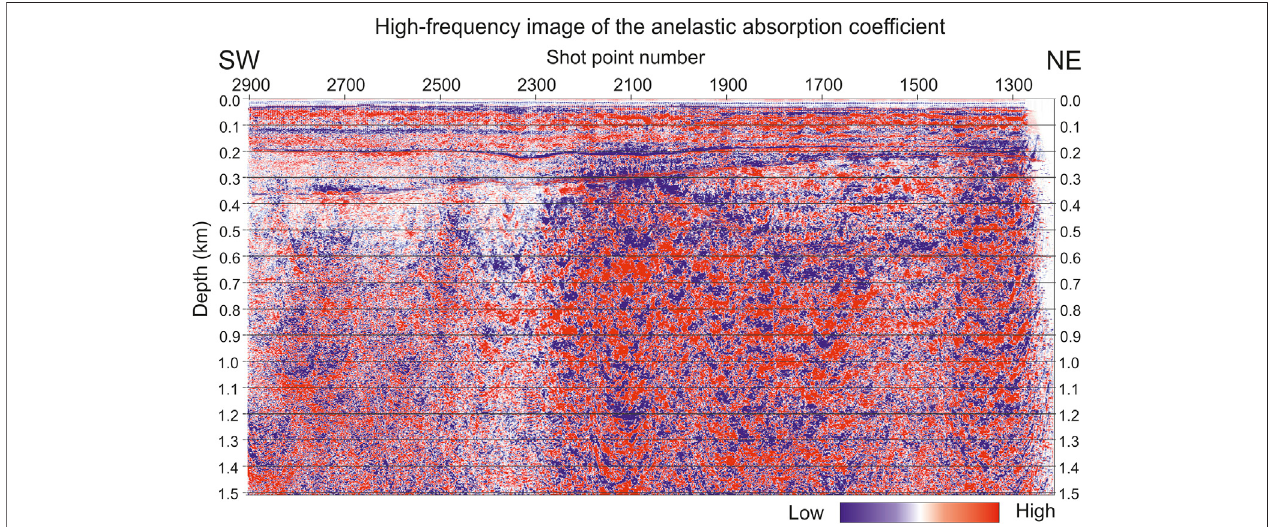
FIGURE 6 | Depth migrated and derived instantaneous frequency of the line GT09 – 21, i.e., the high-frequency component of the anelastic absorption coef fi